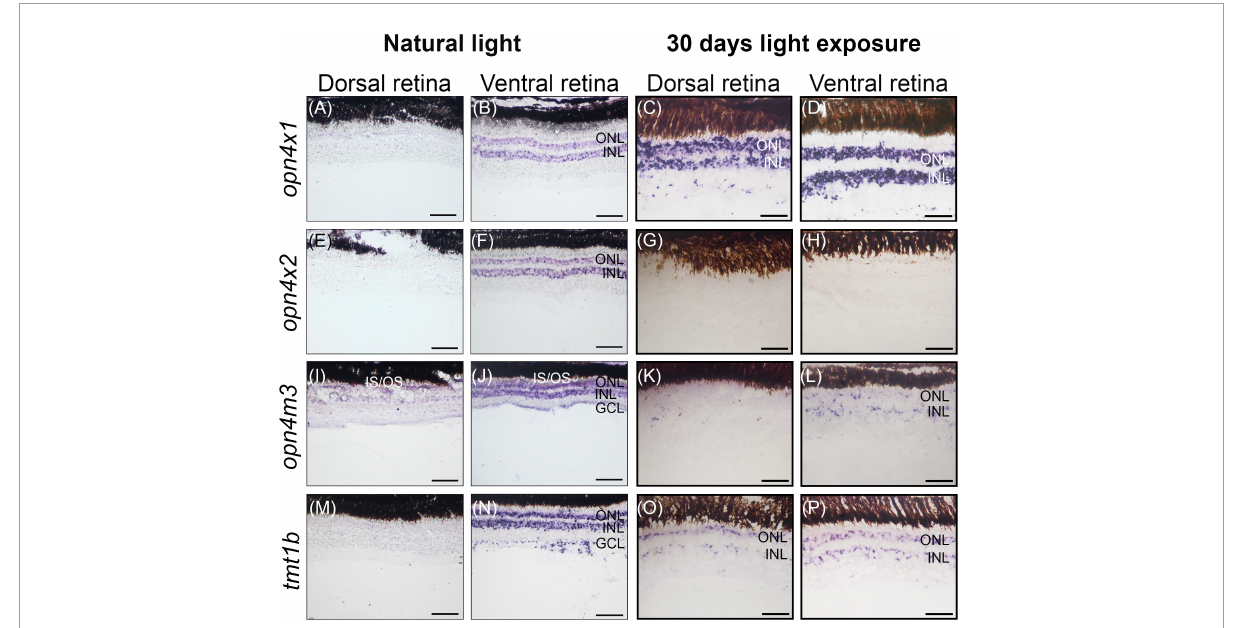
FIGURE3 Non-visual opsin gene expression in the juvenile retina of Anableps anableps . In situ hybridizations of opn4 × 1 (A–D) , opn4 × 2 (E–H) , opn4m3 (I–L) , and tmt1b (M–P) were performed in A. anableps ’ eyes from wild-caught juvenile fish under natural light conditions (A,B,E,F,I,J,M,N) and juveniles that were kept for 30 days in light exposure from above and below the water (C,D,G,H,K,L,O,P) . The panel shows sections of the dorsal retina and ventral retina. ONL, outer nuclear layer; INL, inner nuclear layer; GCL, ganglion cell layer; IS, photoreceptor inner segments; OS, photoreceptor outer segments. Scale bars: 0.05 mm.